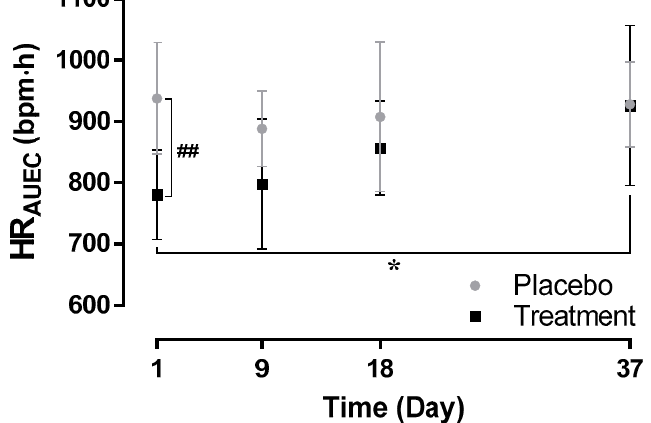
Figure 2. Hourly mean heart rate area under the e ff ect curve (HR AUEC ) based on the 0–12 h interval by treatment group. Arithmetic mean HR AUEC from 0–12 h following single-dose administration of 10 mg ponesimod alone (Day 1), at approximately 50% steady state of 2 mg once daily cenerimod (Day 18), at steady-state cenerimod (Day 37), and following first-dose administration of cenerimod (Day 9). Active treatment is displayed in black, n = 8. Placebo data of the corresponding days are displayed in grey, n = 4. Data were derived from 24 h Holter ECGs. Error bars represent standard deviation. * p < 0.05 Treatment Day 1 versus Day 37; ## p < 0.01 placebo versus treatment on Day 1; Student’s t -test.